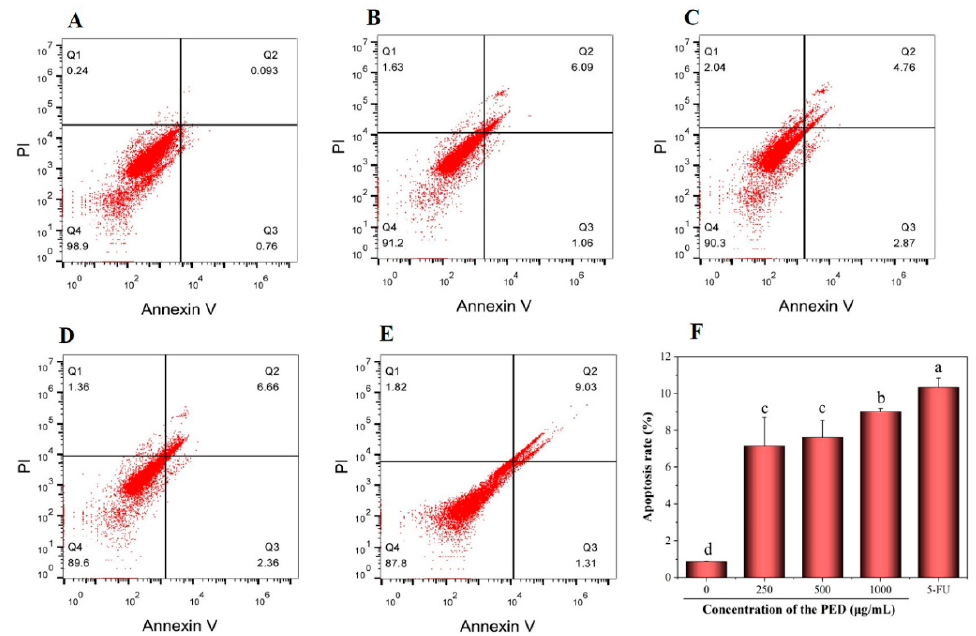
Figure 7. Effect of different doses of PED on apoptosis of HepG2 cells. ( A ): untreated cells; ( B – D ): 250, 500, and 1000 μ g/mL; ( E ): 5-FU; ( F ): Analysis of apoptosis rate of HepG2 cells. 5-FU: 5-Fluorouracil. Different lowercase letters indicate significant differences ( p < 0.05).